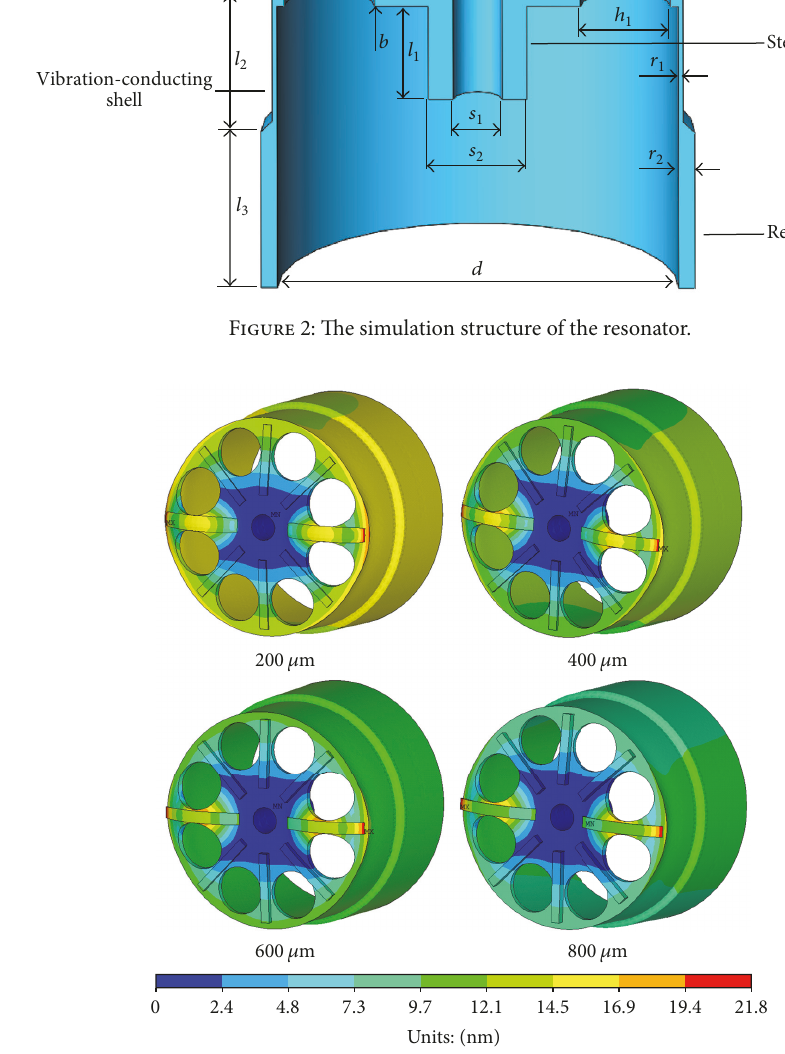
of the electrodes. The resonant frequencies were obtained